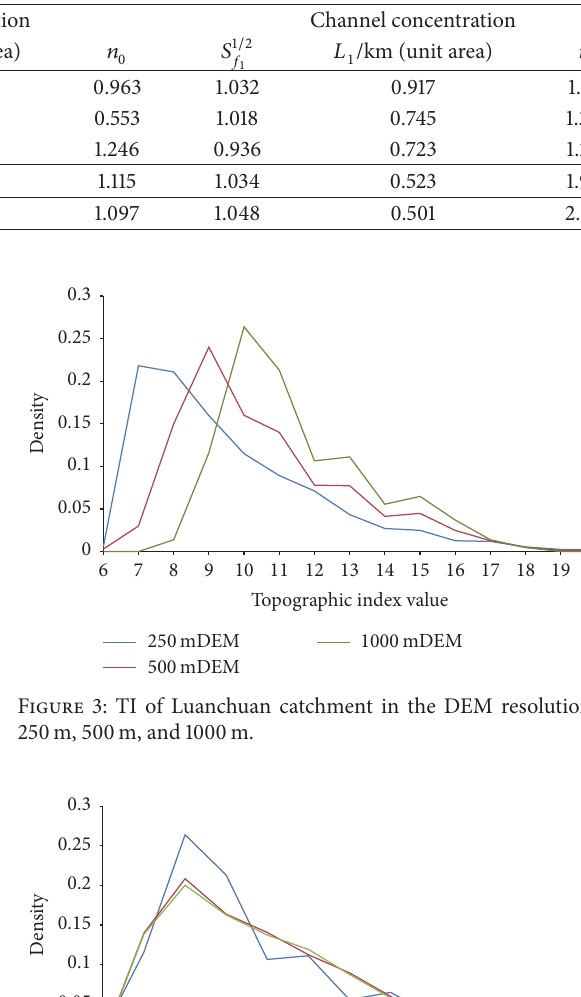
Table 3: Relations among concentration parameters.